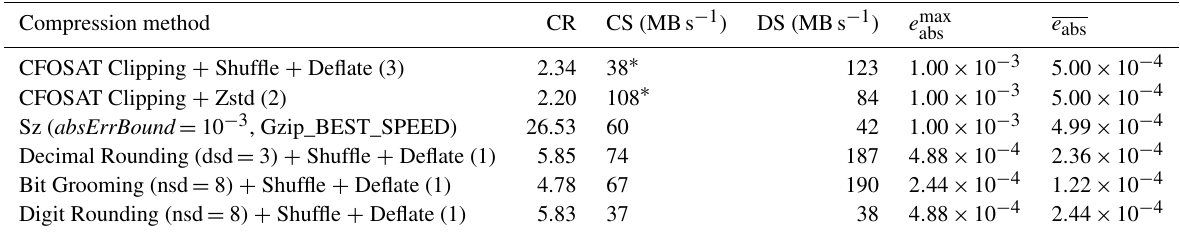
Table 8. Compression results for the ground_range_5 variable in the CFOSAT L1A product. Compression method